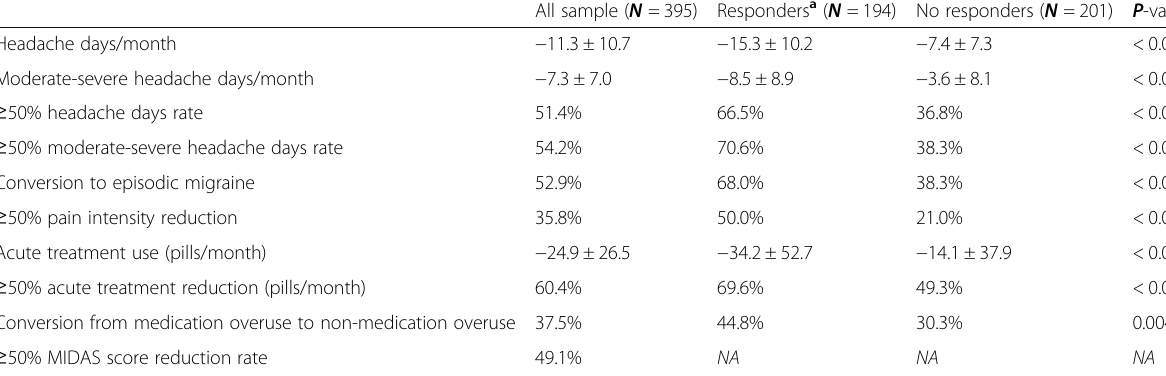
Table 2 Change in evaluated clinical outcome measures after treatment